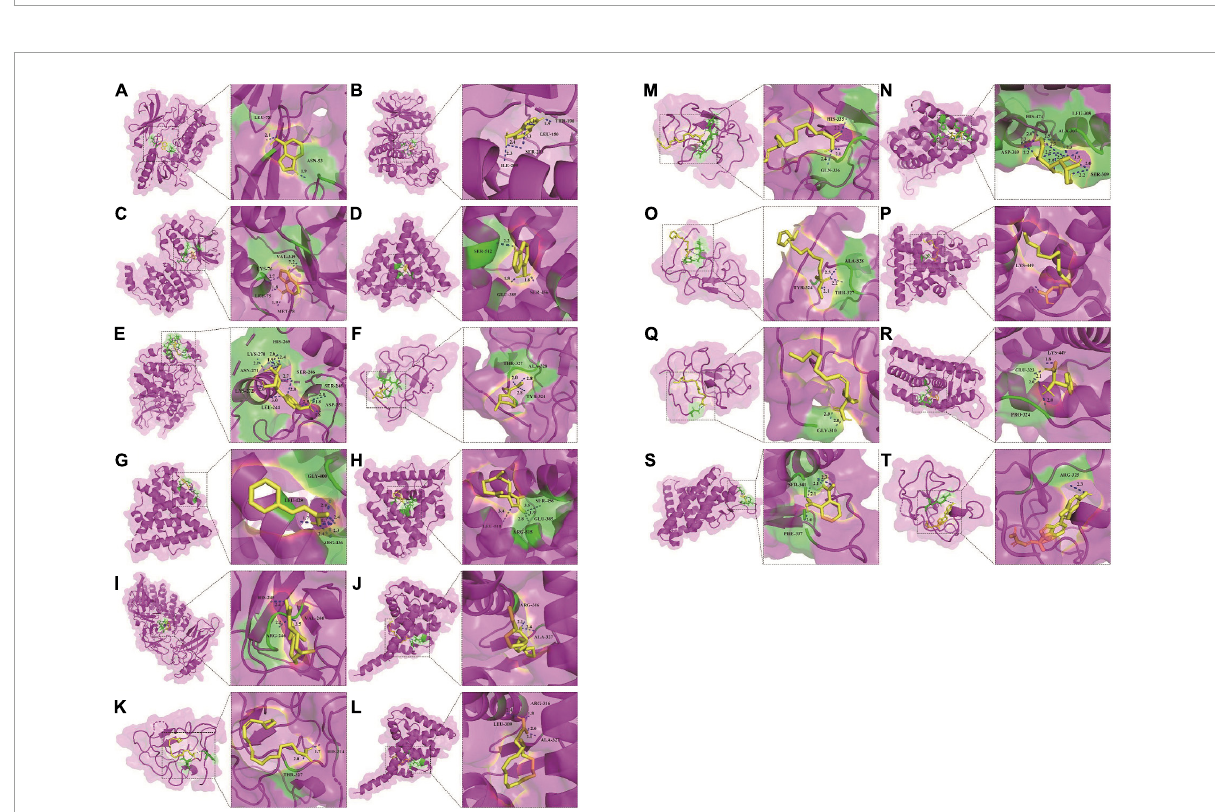
FIGURE6 Molecular docking of 14 active compounds with key targets. (A) Three-dimensional binding mode of adenine and AKT1 (PDB: 3O96). (B) Three-dimensional binding mode of adenine and MAPK1 (PDB: 6SLG). (C) Three-dimensional binding mode of adenine and MAPK14 (PDB: 3PG3). (D) Three-dimensional binding mode of adenine and PIK3CA (PDB: 4A55). (E) Three-dimensional binding mode of adenosine and MAPK1 (PDB: 6SLG). (F) Three-dimensional binding mode of arecoline and JUN (PDB: 6OSN). (G) Three-dimensional binding mode of cinnamic acid and ESR1 (PDB: 5ACC). (H) Three-dimensional binding mode of costunolide and ESR1 (PDB: 5ACC). (I) Three-dimensional binding mode of costunolide and RELA (PDB: 1NFI). (J) Three-dimensional binding mode of linoleic acid and RXRA (PDB: 6JNO). (K) Three-dimensional binding mode of linoleic acid and JUN (PDB: 6OSN). (L) Three-dimensional binding mode of linolenic acid and RXRA (PDB: 6JNO). (M) Three-dimensional binding mode of linolenic acid and JUN (PDB: 6OSN). (N) Three-dimensional binding mode of mannitol and ESR1 (PDB: 5ACC). (O) Three-dimensional binding mode of methyl linoleate and JUN (PDB: 6OSN). (P) Three-dimensional binding mode of palmitic acid and ESR1 (PDB: 5ACC). (Q) Three-dimensional binding mode of palmitoleic acid and JUN (PDB: 6OSN). (R) Three-dimensional binding mode